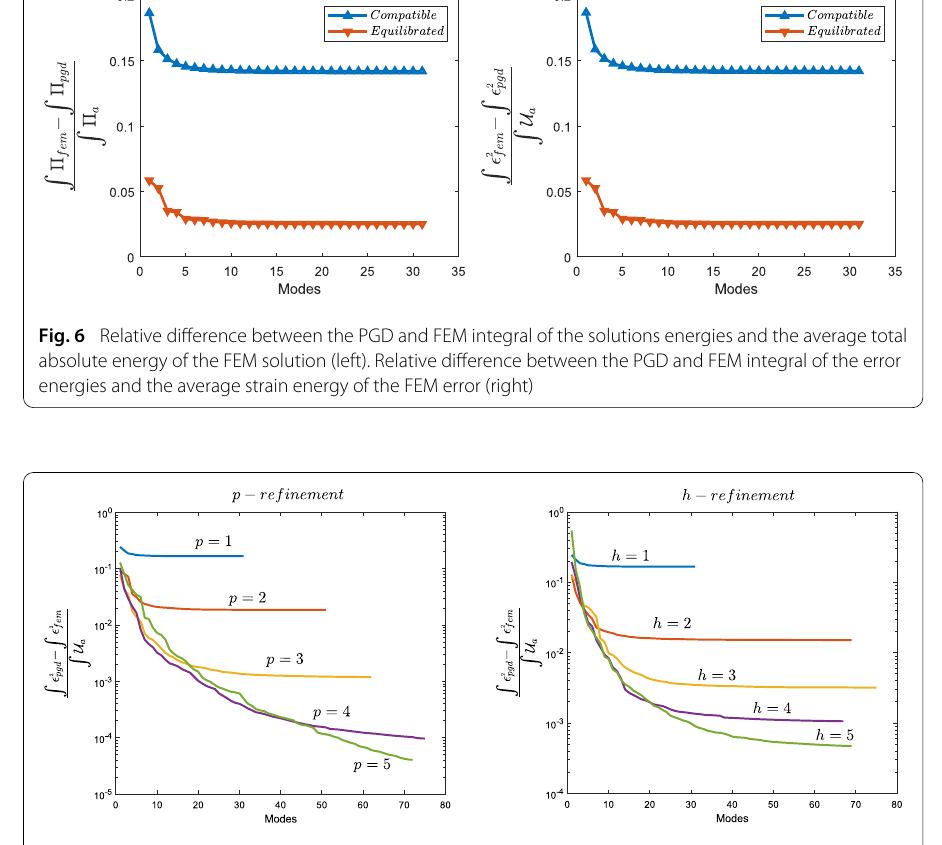
Fig. 7 Relative difference for the integral of the solutions energy and the integral of the error energy for the PGD approximation with different number of degrees and